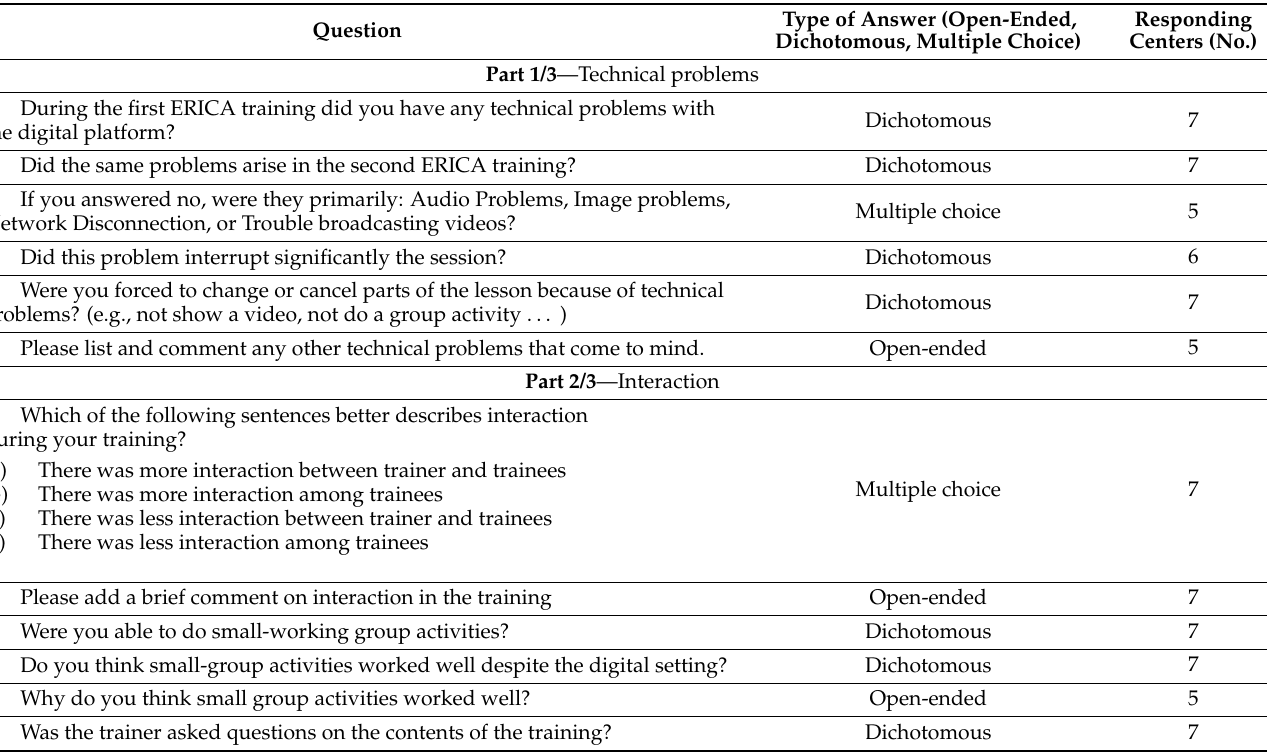
Table A2. Feedback on digital training in the ERICA